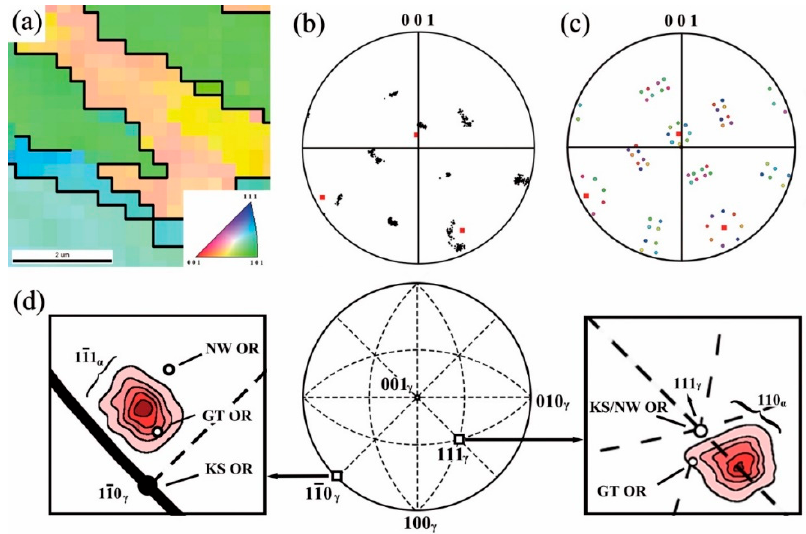
Figure 3. ( a ) The inverse pole figure (IPF) map of α orientations transformed from one γ grain. ( b ) 001 pole figure of α orientations (black dots) and the reconstructed γ orientation (red square dots) in ( a ). ( c ) 001 pole figure of the α orientations (colored dots) predicted by the solved orientation relationship (OR) and the reconstructed γ orientation (red square dots). ( d ) 001 γ standard stereographic projections on which the α directions of 111 α and 110 α are represented by iso-density contours.